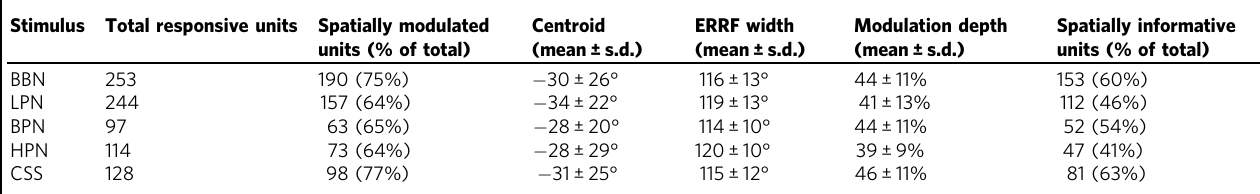
Table 1 Spatial tuning properties of spatially modulated units Stimulus Total responsive units Spatially modulated